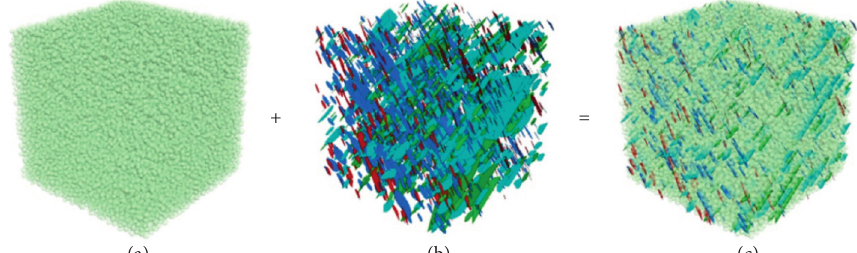
Figure 1: Synthetic rock mass basic components: (a) intact rock; (b) DFN; (c) SRM.